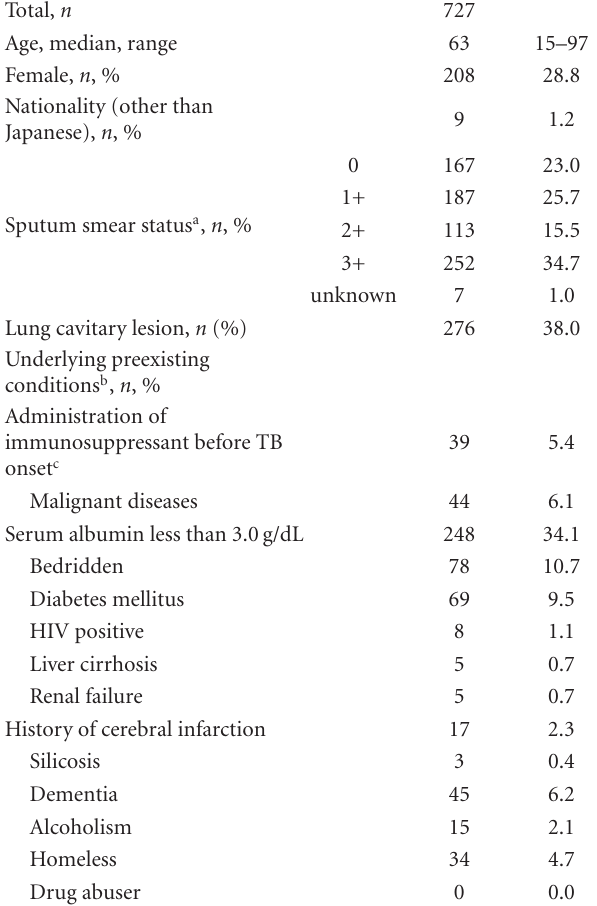
Table 1: Demographic and baseline clinical characteristics of pulmonary tuberculosis